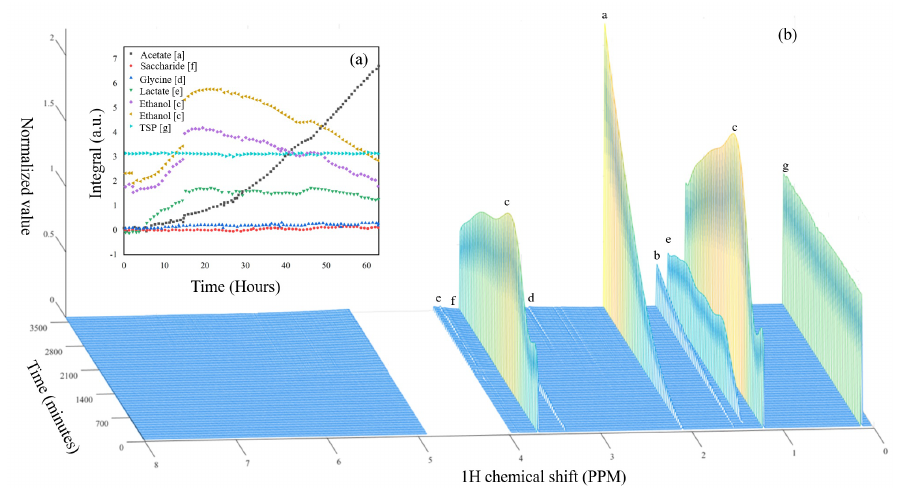
Figure 4. ( a ) Area under the curve for significant peaks seen at the output over three days of continuous real-time NMR monitoring of the bio-reaction of orange peel fed to T. reesei . Note: only 80 data points are plotted for clarity. ( b ) Real-time acquired spectra of the 516 runs plotted in 3D with water peak and stationary peaks (except 3-(trimethylsilyl)propionic-2,2,3,3-d 4 acid sodium salt (TSP)) removed. Note: only 52 in 516 runs are plotted for better visualization. X-axis is chemical shift (ppm) axis, y axis is time point and z axis is normalized value with respect to TSP. Abbreviations: (a)—acetate; (b)—alanine; (c)—ethanol; (d)—glycine; (e)— lactate; and, (f)—saccharide,